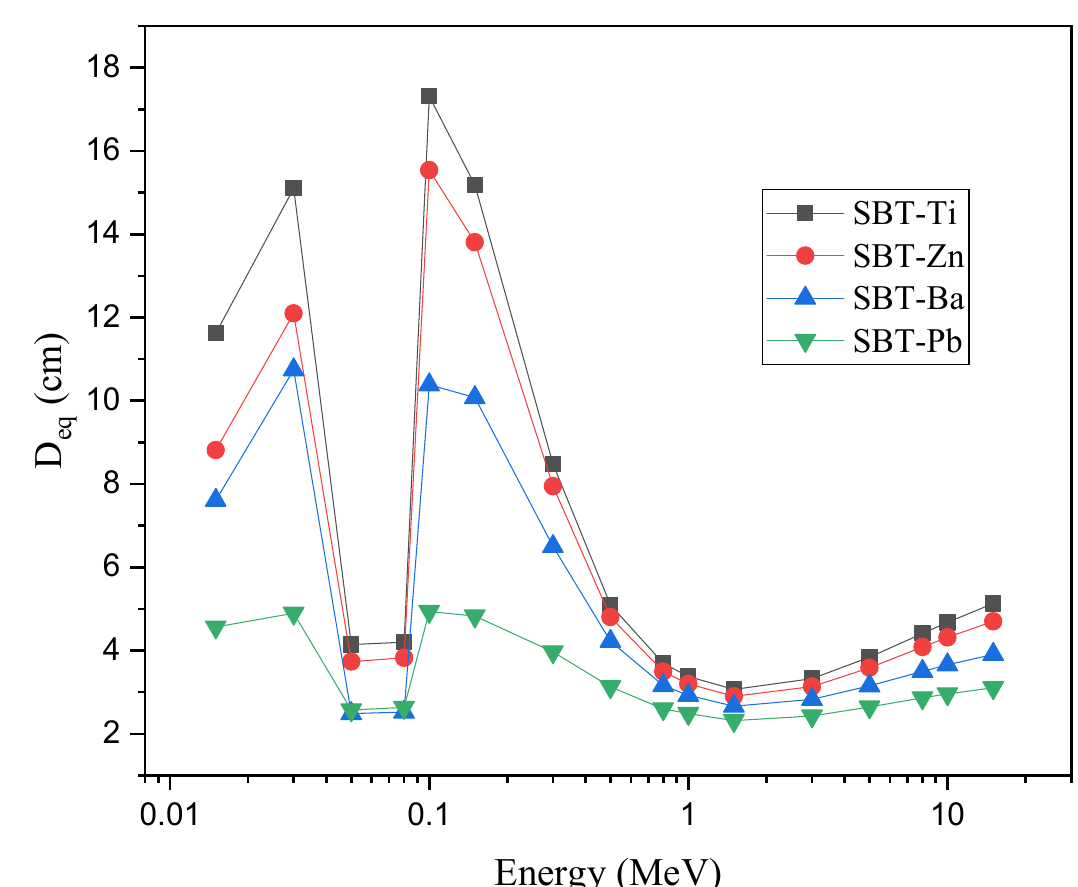
Figure 8. The samples’ thickness equal to 1 cm of lead at different gamma-ray energy. The transmission factor (TF, %) measures the photon numbers that can penetrate or escape from the shielding material. In contrast, the radiation protection efficiency (RPE, %) measures the number of photons that the shielding material can stop or absorb during the interaction. Both TF and RPE were investigated for the fabricated glasses and presented in Figure 9 versus the incident gamma-ray photon. Figure 9a shows that the TF values at low gamma-ray energy up to 0.1 MeV are very small due to the photoelectric interaction, which consumes the low energy of photons totally in the interaction to produce a